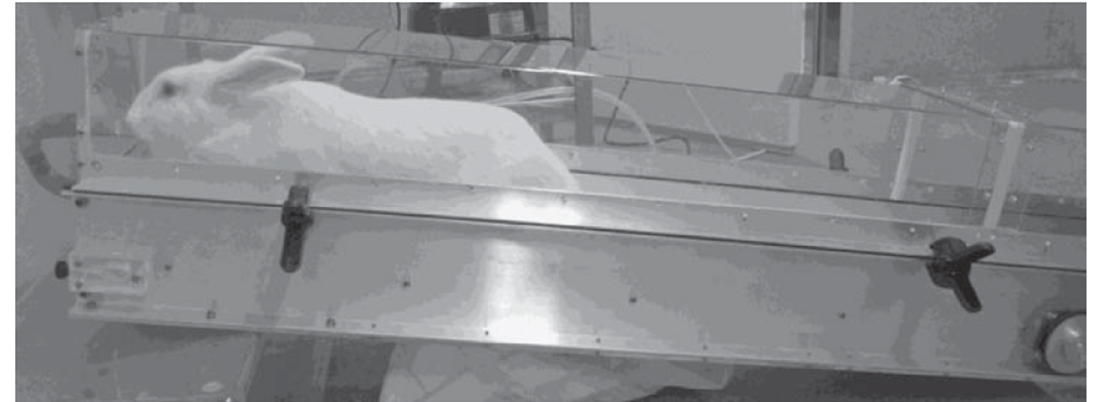
Figure 1. Adjustable speed and tilt treadmill. Adapted from Gaustad et al. [21].